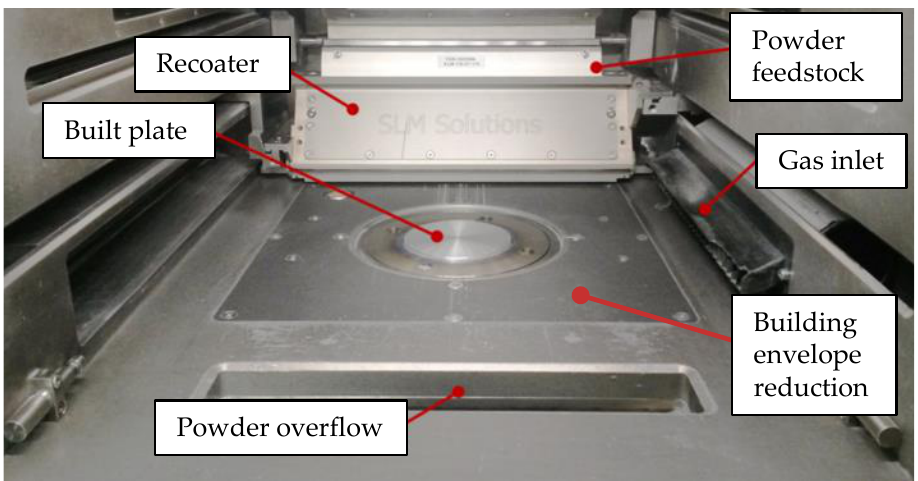
Figure 1. SLM 280 HL with installed building envelope reduction.